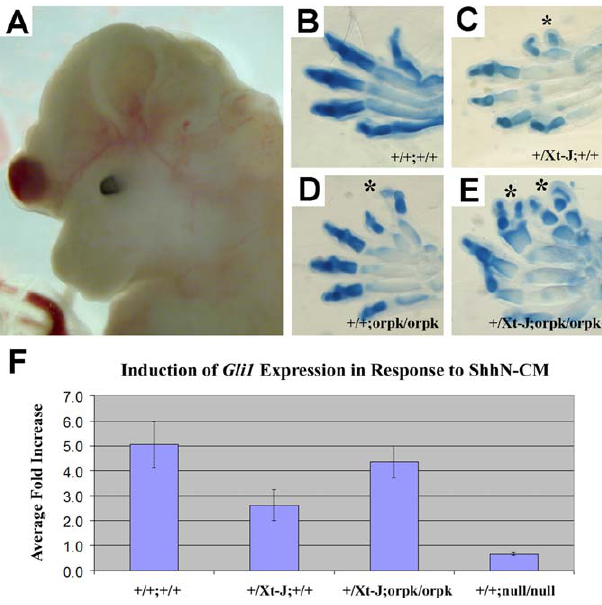
Figure 4. Gli3 Xt-J/ þ ; Tg737 orpk/orpk Embryos Resemble Gli3 Xt-J/Xt-J Null Embryos and Are Responsive to ShhN-CM (A) Example of exencephaly observed in Gli3 Xt-J/ þ ; Tg737 orpk/orpk embryos that is never observed in Gli3 Xt-J/ þ or Tg737 orpk/orpk mutants alone. (B–E) Functional interaction of Gli3 and Tg737 in digit development. Whereas Gli3 Xt-J/ þ (C) and Tg737 orpk/orpk (D) embryos each develop